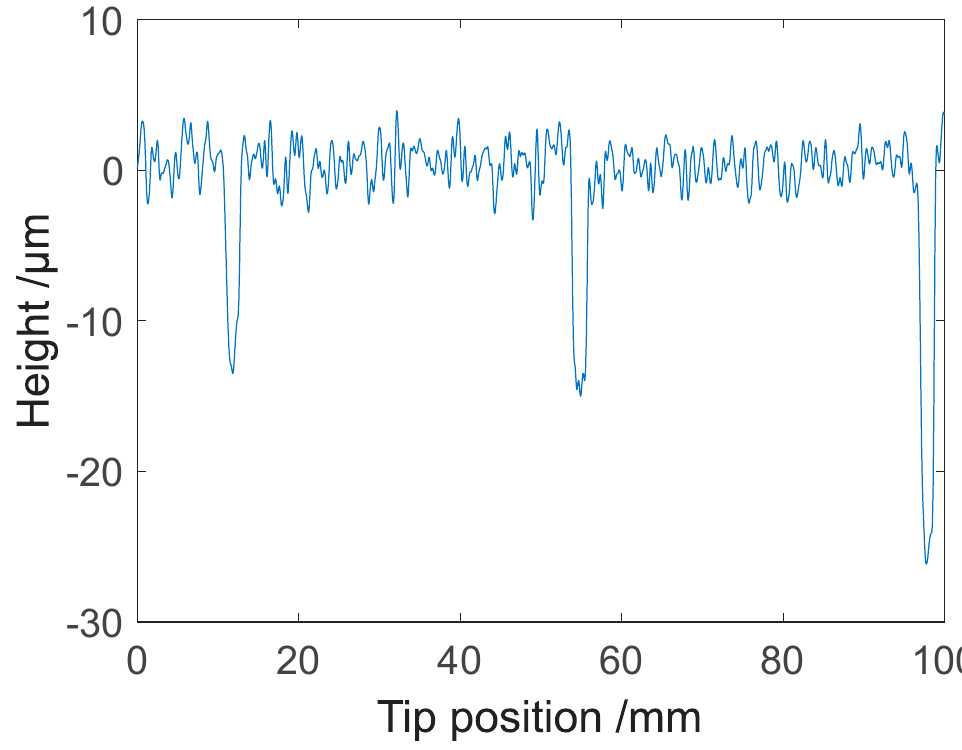
Figure 14. Waviness profile with Gaussian filter and 0.8 mm cut off. Three valleys with depths over 10 µm are visible.